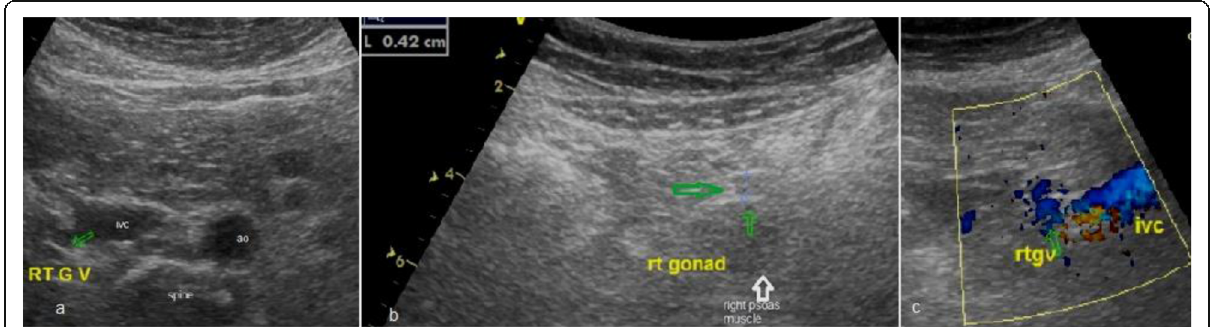
Fig. 5 a , b Trans-abdominal ultrasound and c color Doppler images showing right gonadal vein at its connection with the IVC (open green arrow in a ) and its measurement (diameter = 4.2 mm open green arrows in b ) seen anterior to the psoas muscle (open white arrow) in ( b ). Right gonadal vein competence (open green arrow) in ( c ) was demonstrated (coded in blue) taking the same color of the adjacent IVC (ivc)